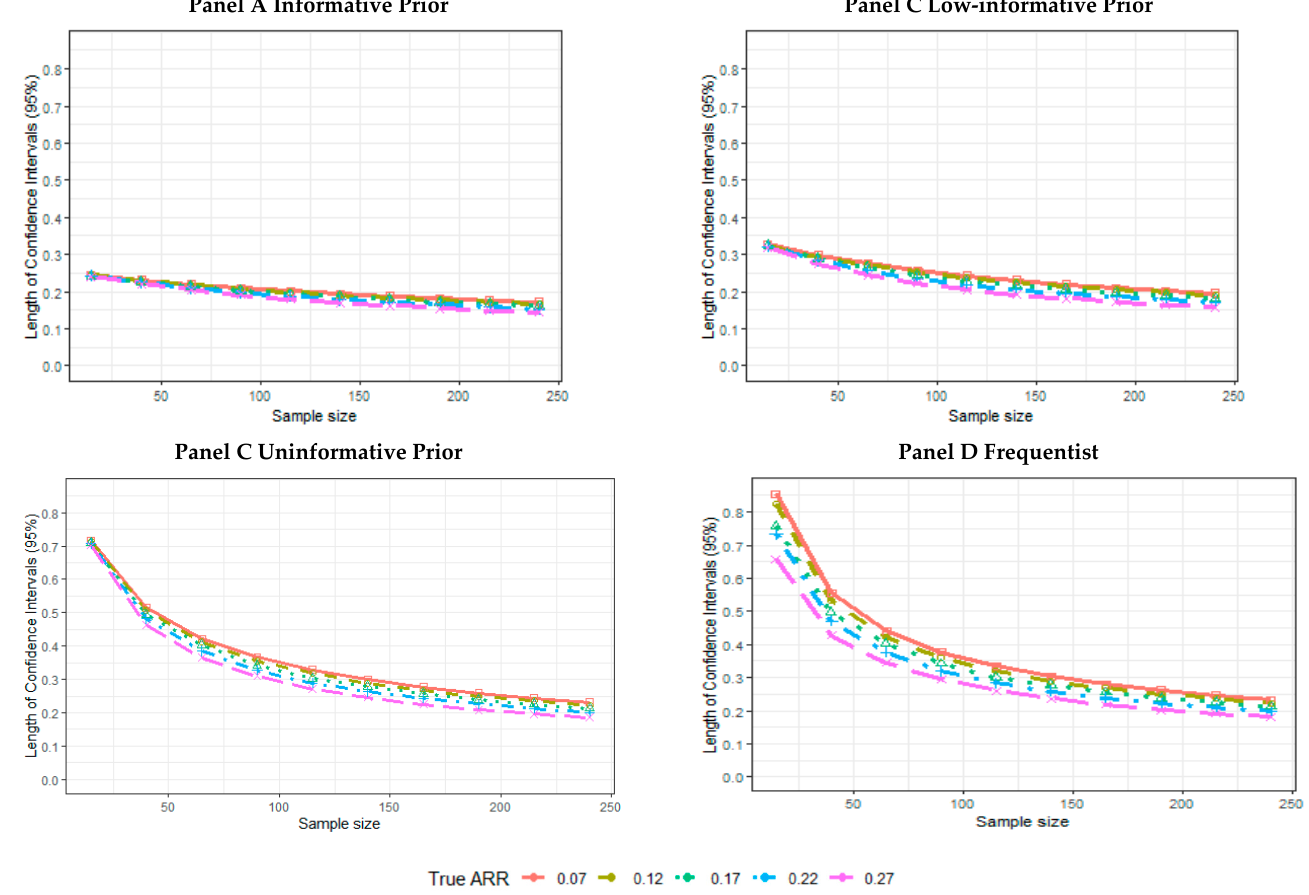
Figure 3. Simulation results for the 95% CI length according to the sample size and true ARR for informative prior (Panel A), low ‐ informative prior (Panel B), uninformative prior (Panel C), and frequentist analyses (Panel D).